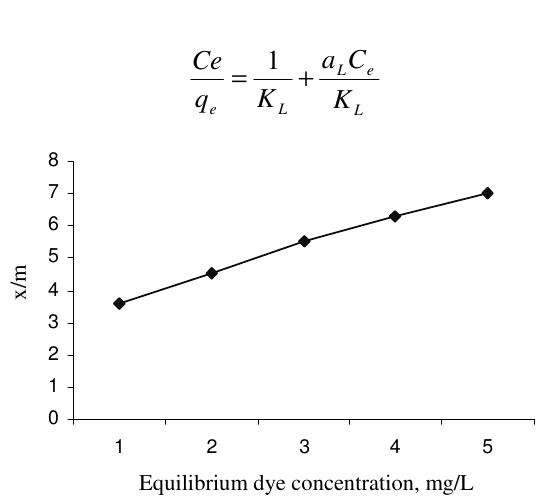
Figure 4. Equilibrium adsorption of Grey BL.